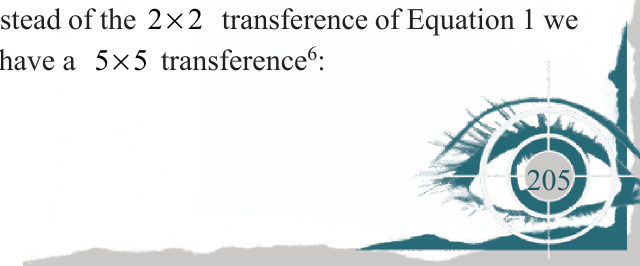
Figure 2 Deflection a ∆ (given by Equations 40 and 42) and transverse translation y ∆ (Equations 39 and 41) of a ray through an arbitrary system S in linear optics. This is a three- dimensional generalization of Figure